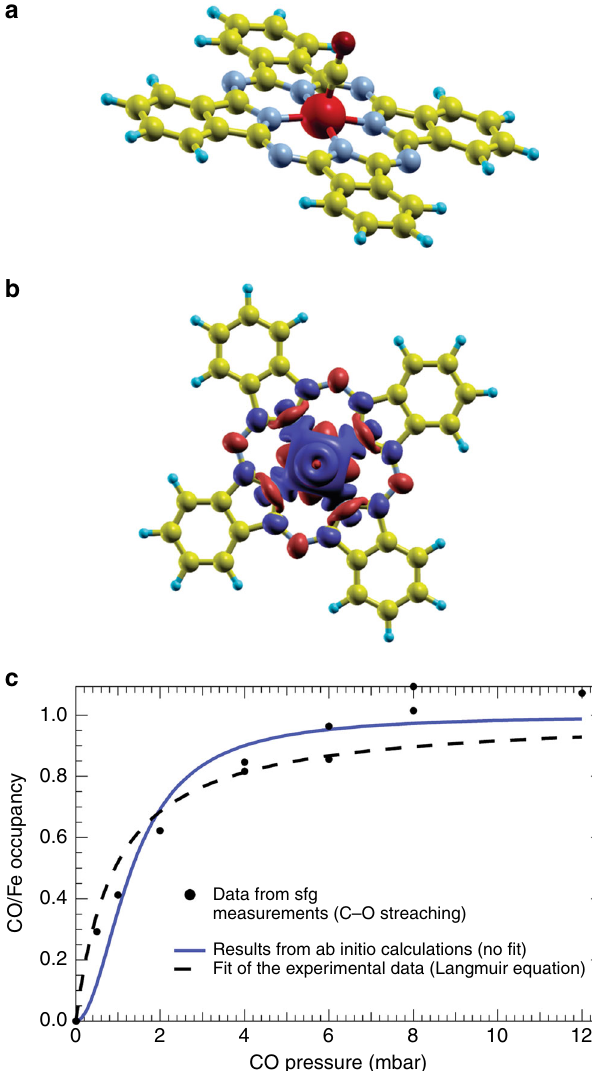
Fig. 2 Carbonylation of the FePc monolayer on graphene. a Adsorption geometry for a single CO molecule on FePc. b Spin polarization ( ρ up – ρ down ) for the triplet obtained in DFT + U (blue: negative values; red: positive values). c Relative coverage of the adsorption sites of a layer of FePc molecules as a function of the CO pressure. The experimental data (dots) are affected by an error of roughly ± 0.1 on the vertical axis. The theoretical curve (blue, solid line) is obtained within the framework of a pure ab initio approach, while the experimental data are fi tted by a Langmuir isotherm (black, dashed line)